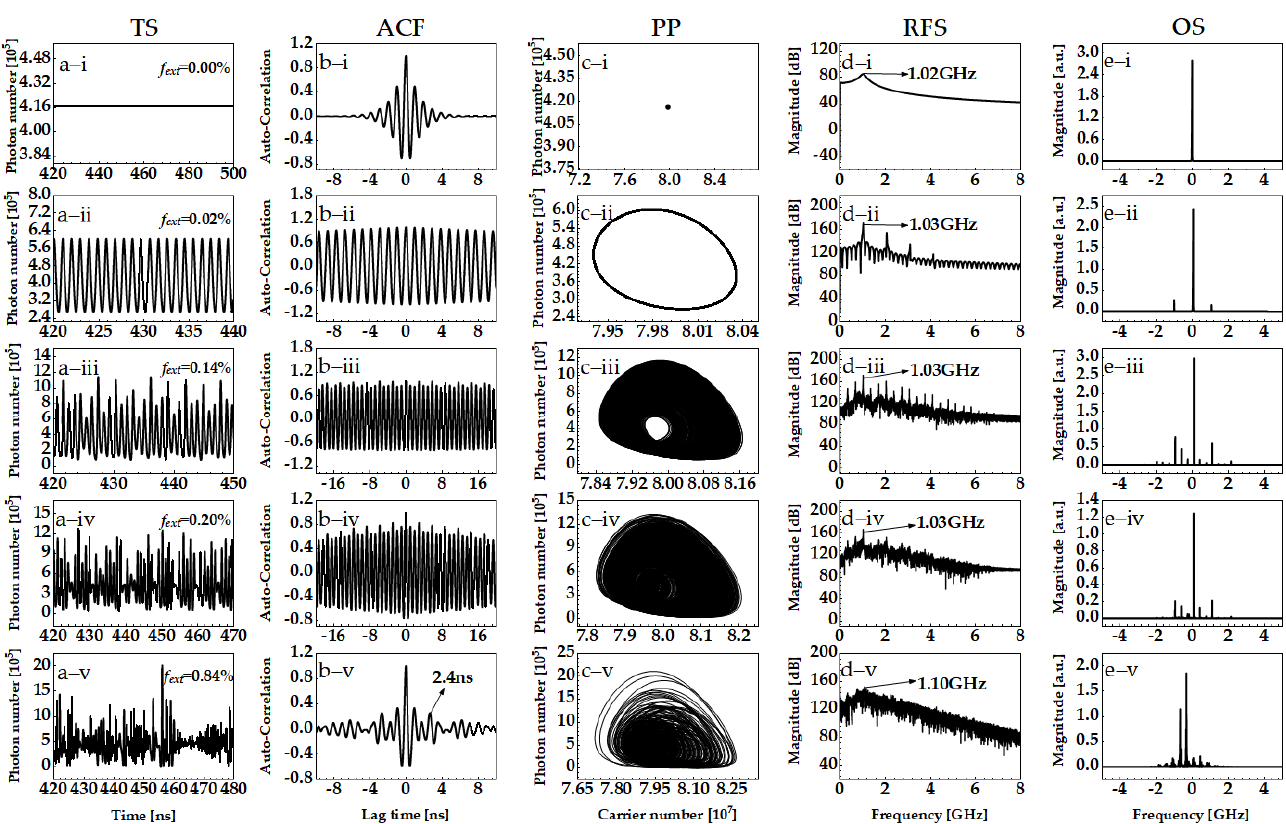
Figure 3. Output of ICL with external optical feedback as feedback strength increases with m = 5, I = 1.1 I th , and τ f = 2.4 ns; from the top down, i: f ext = 0.0%, ii: f ext = 0.02%, iii: f ext = 0.14%, iv: f ext = 0.20%, v: f ext = 0.84%; columns ( a – e ) are time series (TS), autocorrelation curve functions (ACF), phase portrait (PP), radio-frequency spectrum (RFS) and optical spectra (OS), respectively.